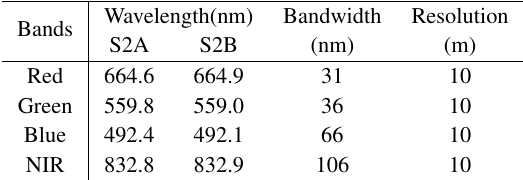
Table 1. Data Description from (European Space Agency, 2015). S2A and S2B are the two satellites respectively. Wavelength is the central